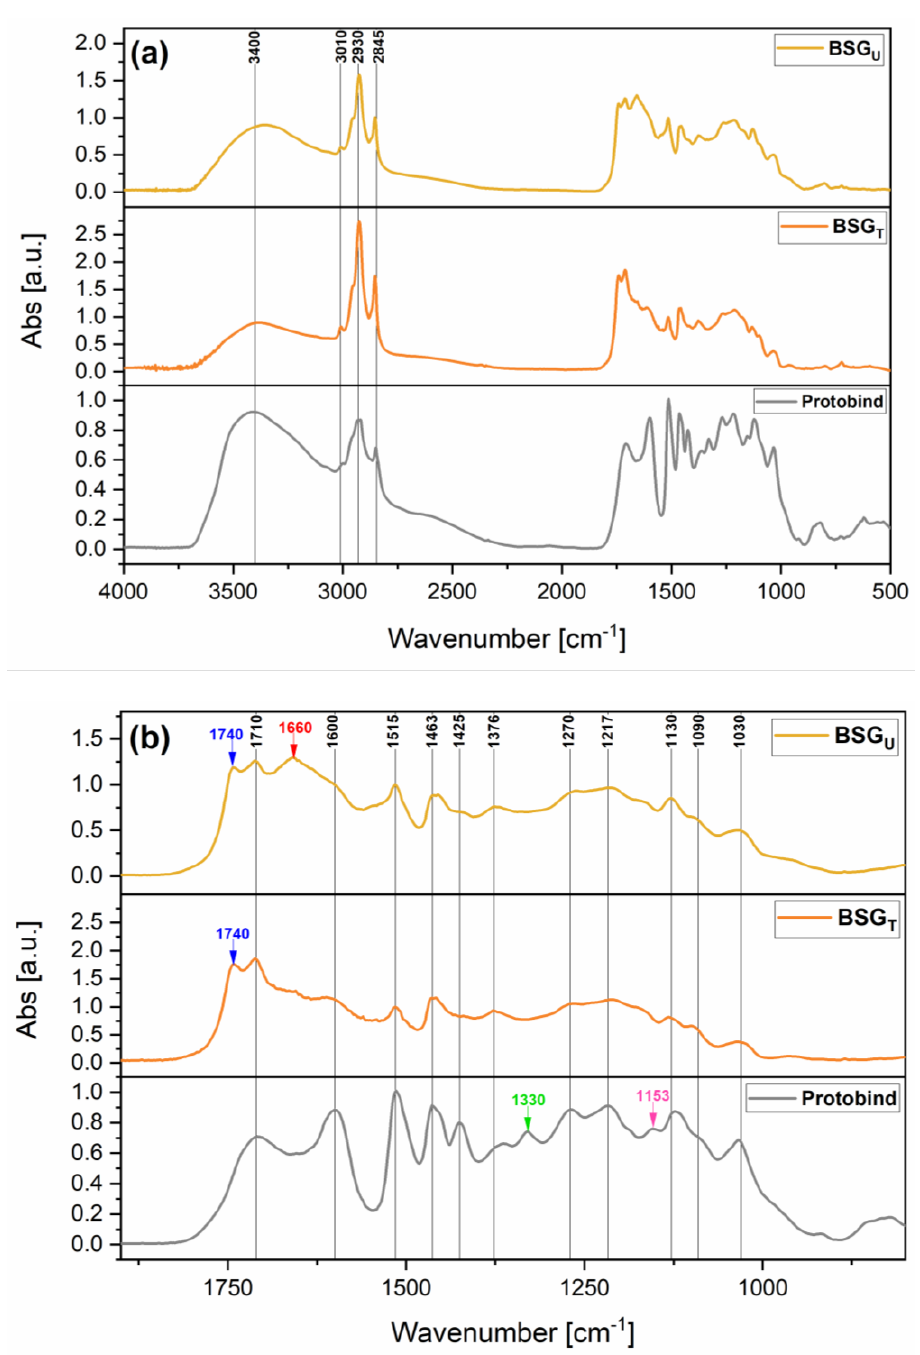
Figure 7. ( a ) FT-IR spectra of BSG U Lignin, BSG T Lignin, and Protobind; ( b ) zoomed view of the fingerprint region.